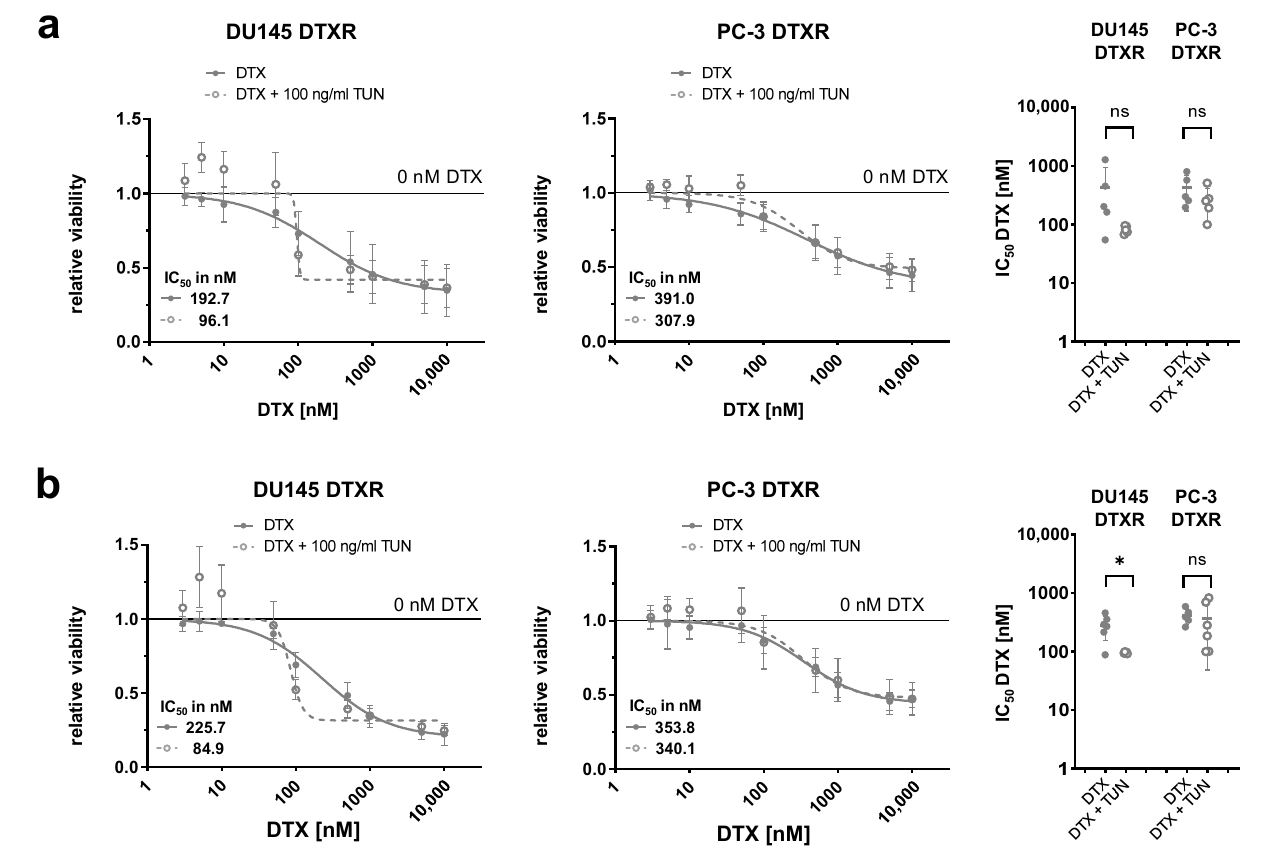
Figure 7. Influence of tunicamycin-mediated deglycosylation of ABCB1 protein in combination with DTX on cellular viability of DU145 and PC-3 DTXR cells. DU145 and PC-3 DTXR cells with or without pre-treatment with 100 ng/mL tunicamycin (TUN) for 96 h were treated with a serial dilution of DTX. After treatment, the metabolic activity and the total adherent cell mass were determined by ( a ) the WST-1 assay and ( b ) the crystal violet assay, respectively, and IC 50 values for DTX were calculated. The adjacent graphs to the right depict IC 50 values calculated from individual experiments. All data were normalized to the indicated control (black line). Data are depicted as mean ± SD of four to six independent biological replicates. Non-paired t-test with Welch’s correction for comparison of two treatment groups: * p < 0.05, ns: not